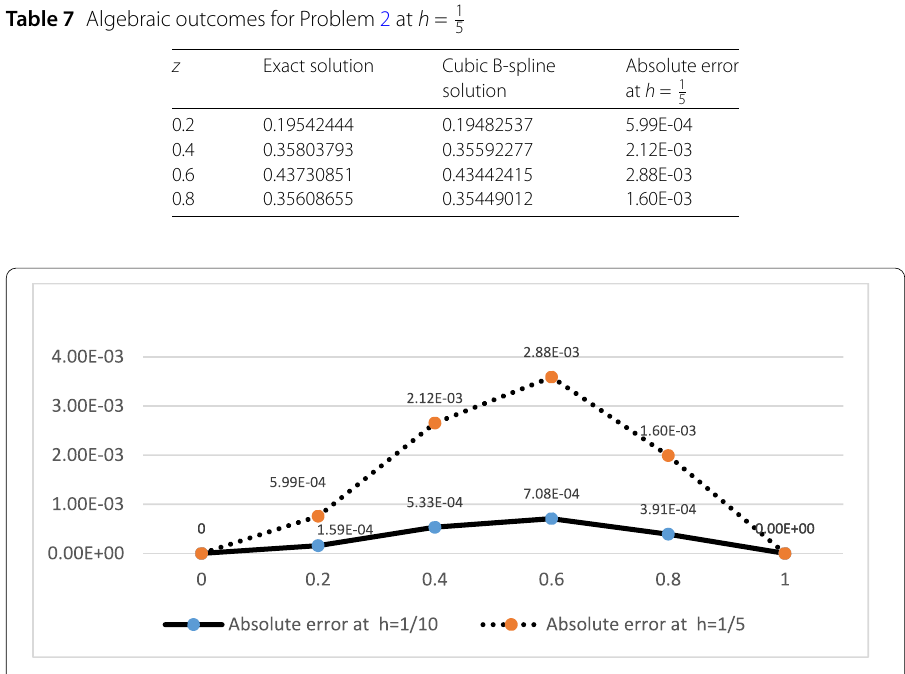
Table 7 Algebraic outcomes for Problem 2 at h = 1